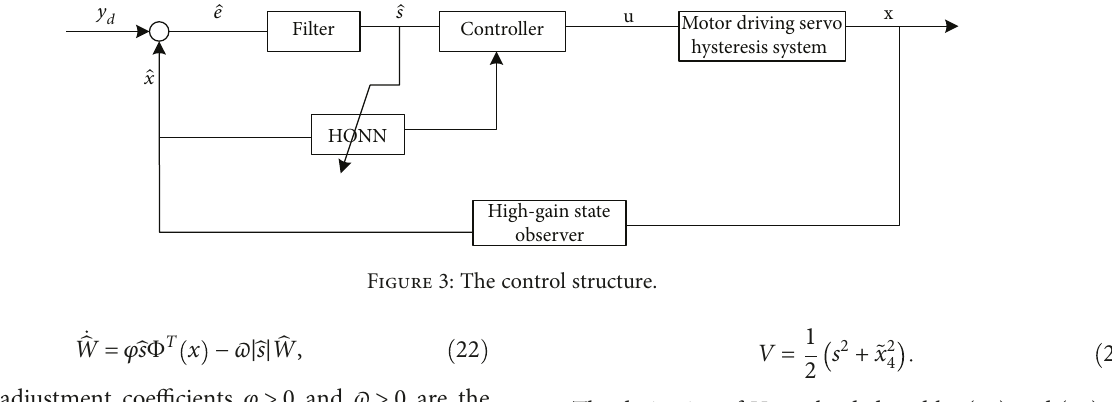
Figure 3: The control